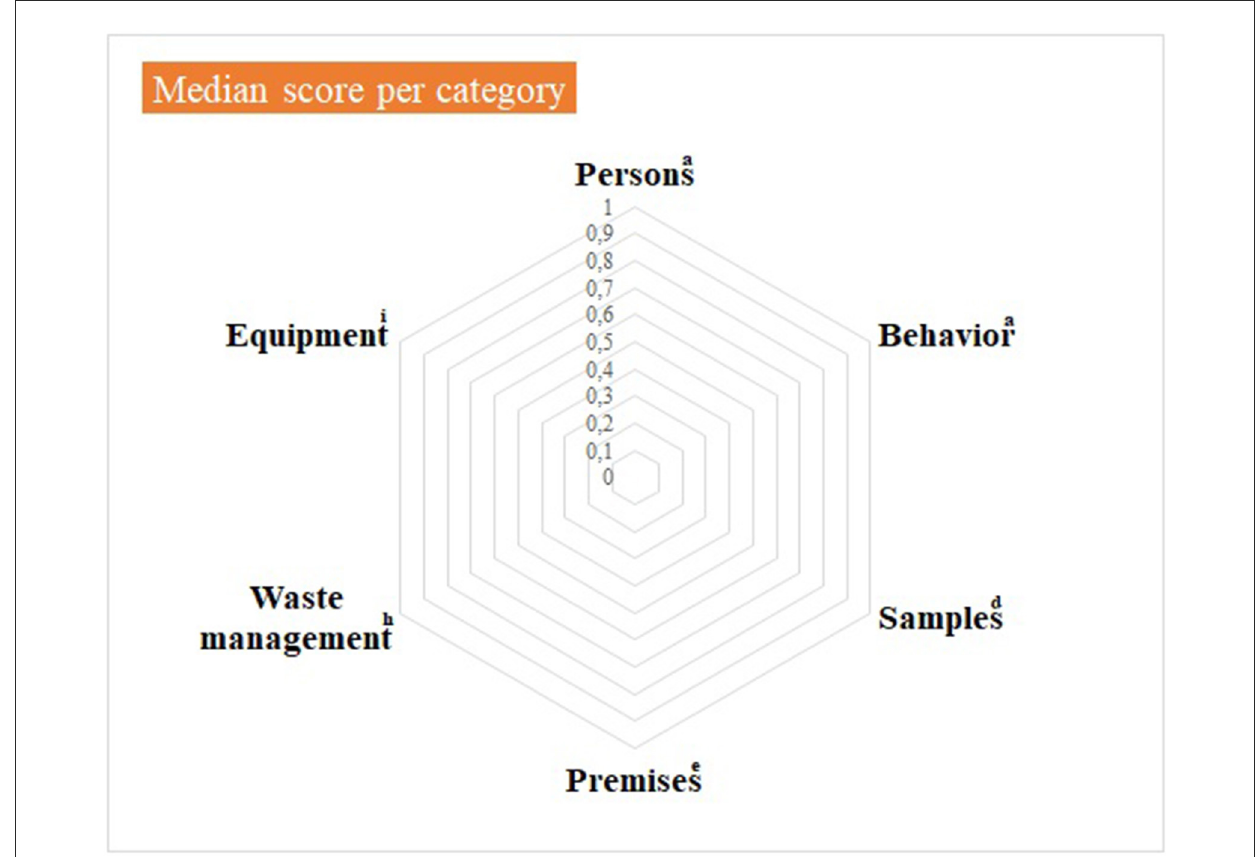
FIGURE3 Virology practical sessions—median score per component of the internal biosecurity audit. a For the categories “Persons” and “Behavior”, N observations ( = number of people observed per category) = 14 students of 2nd bachelor in veterinary medicine (BVM2) and 4 scientific and technical staff members. d For the category “Samples”, N observations = 1; e For the category “Premises”, N observations = 1 (the lab itself, its preparation for practical activities and cleaning and disinfection process): h For “Waste management”, N observations = 1 (waste disposal equipment present in the lab and anteroom). i For “Equipment”: N observations = 1 for the management of the lab equipment (lab equipment and preparation procedure) and N = 14 for movements of equipment. The number of observations per item appears in Supplementary material